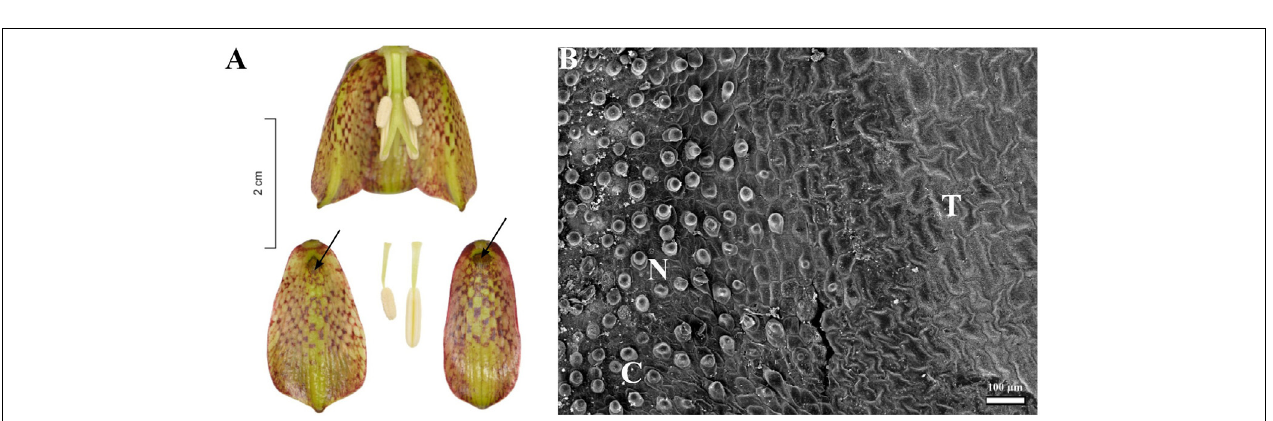
FIGURE 4 | Flowers and nectaries of F. imperialis at full anthesis. Macro and LM images. (A) Flowers and tepals, nectaries marked with arrows. (B) Treatment with Lugol’s iodine solution reveals the presence of starch in secretory and subsecretory parenchyma. Grains visible in the plastids of subepidermal cells in F. imperialis outer tepal nectaries.